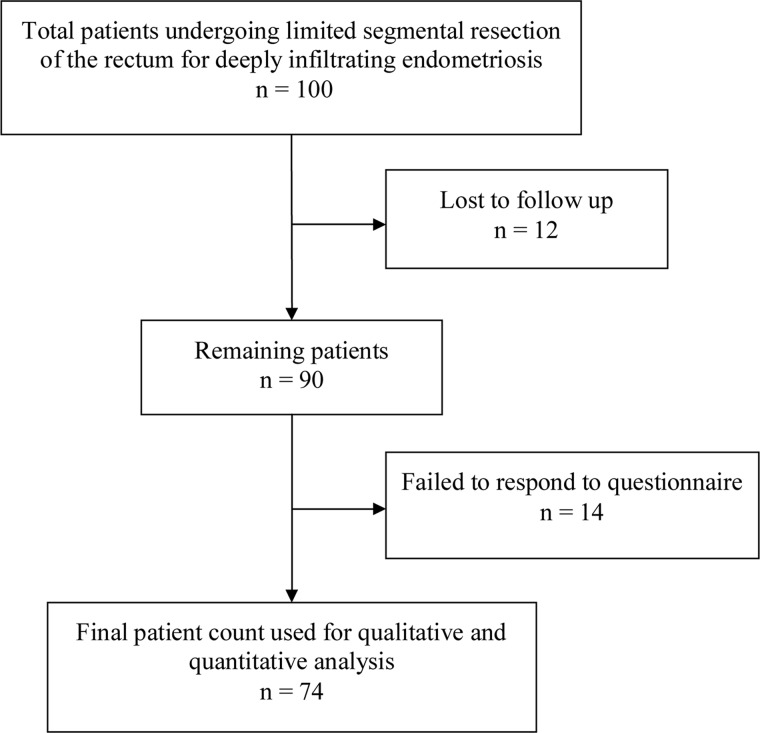
Study flow diagram.